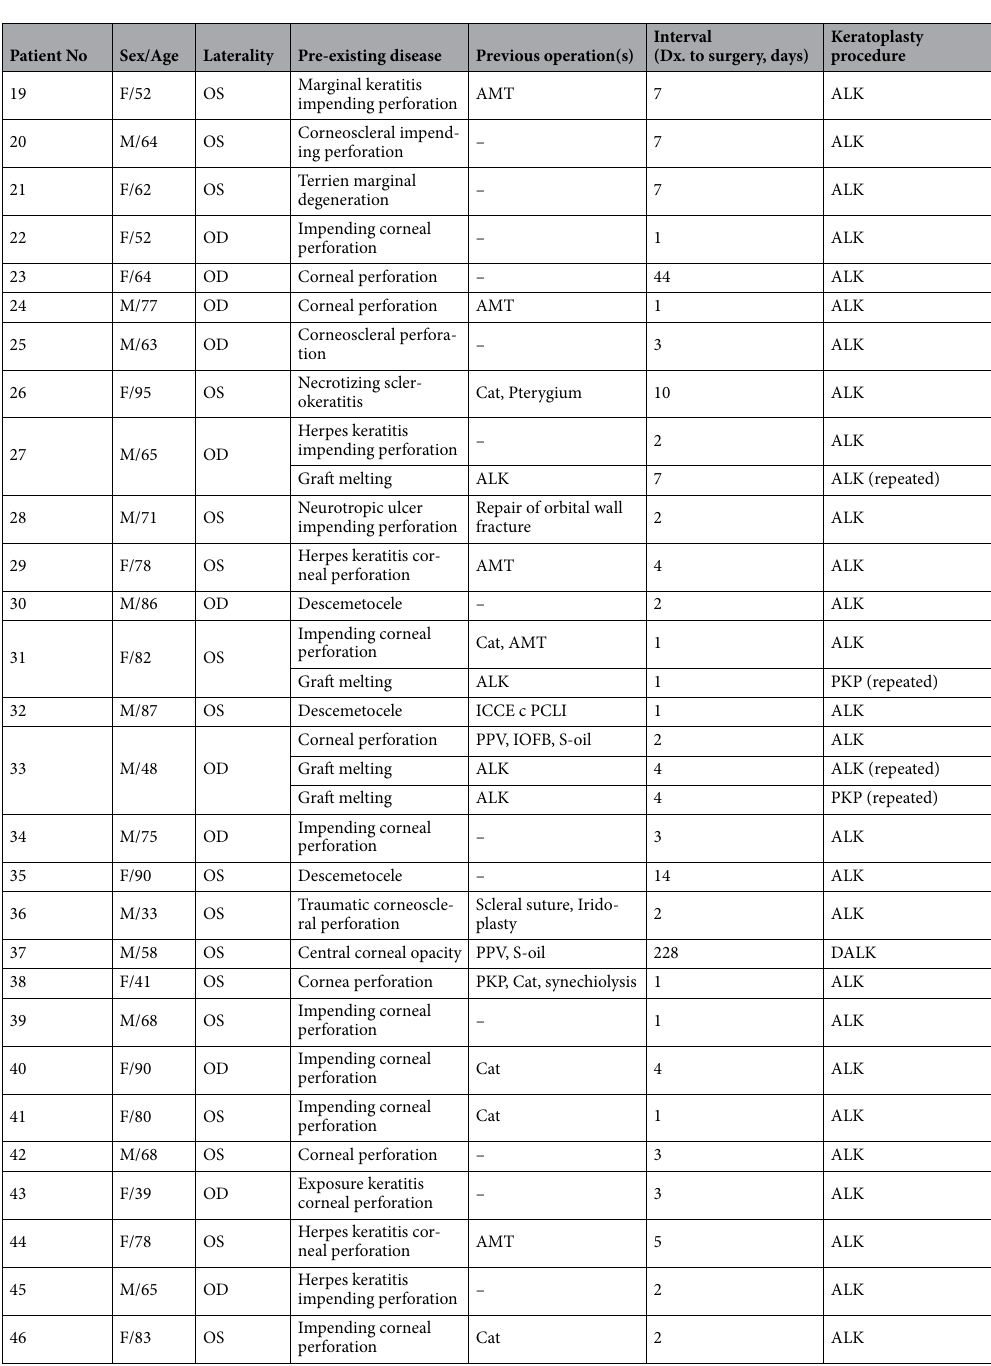
Table 4. Preoperative demographics of patients undergoing tectonic keratoplasty using cryopreserved cornea. No.—number; Dx.—diagnosis; M—male; F, female; OD—oculus dexter; OS—oculus sinister; Cat—cataract surgery; AMT—amniotic membrane transplantation; ICCE c PCL—intracapsular cataract extraction with posterior capsular lens implantation; PPV—pars plana vitrectomy; IOFB—intraocular foreign body; S-oil— silicone oil; ALK—anterior lamellar keratoplasty; PKP—penetrating keratoplasty; DALK, deep anterior lamellar